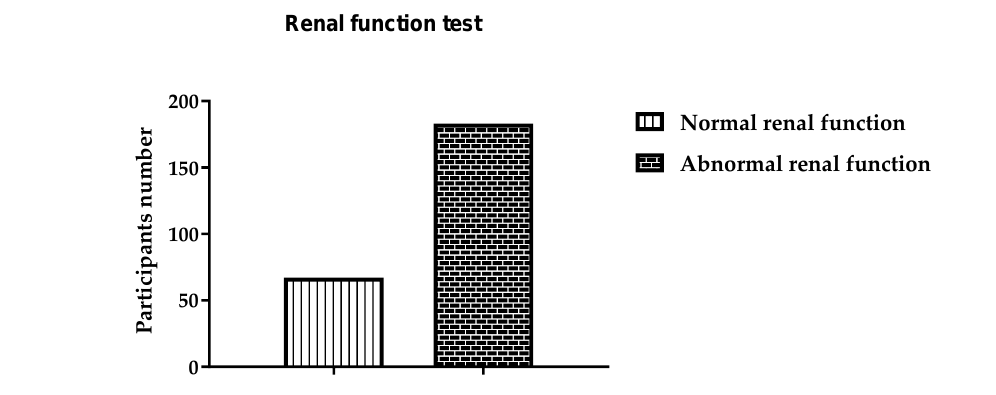
Figure 3. Renal function test results of all participants.